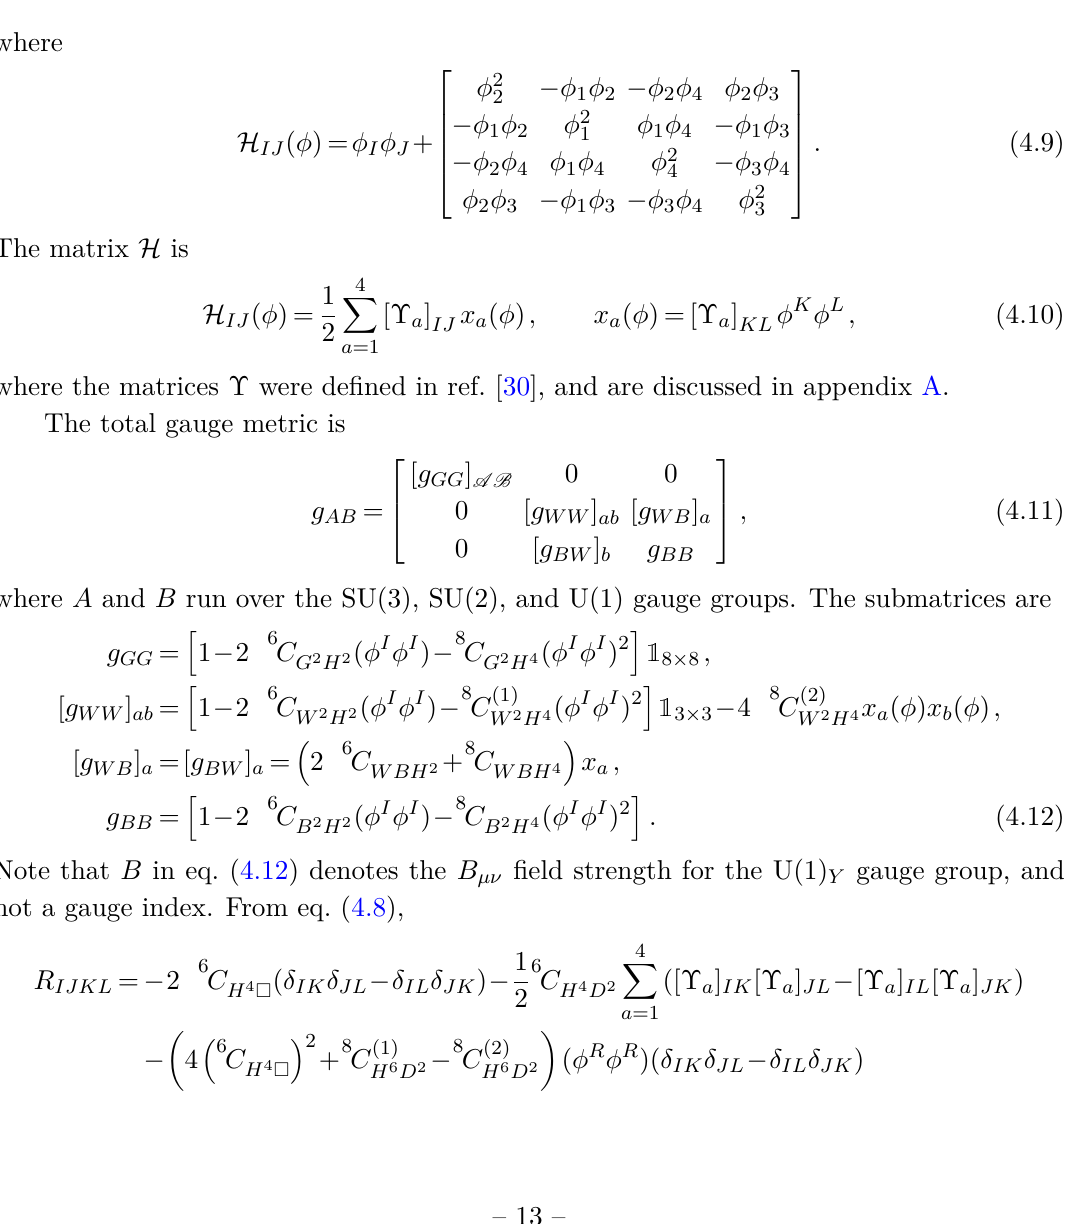
Table 3 . Bosonic even-parity dimension-six operators in the SMEFT. The first column is the notation of ref. [29], and the second column is the notation used in this